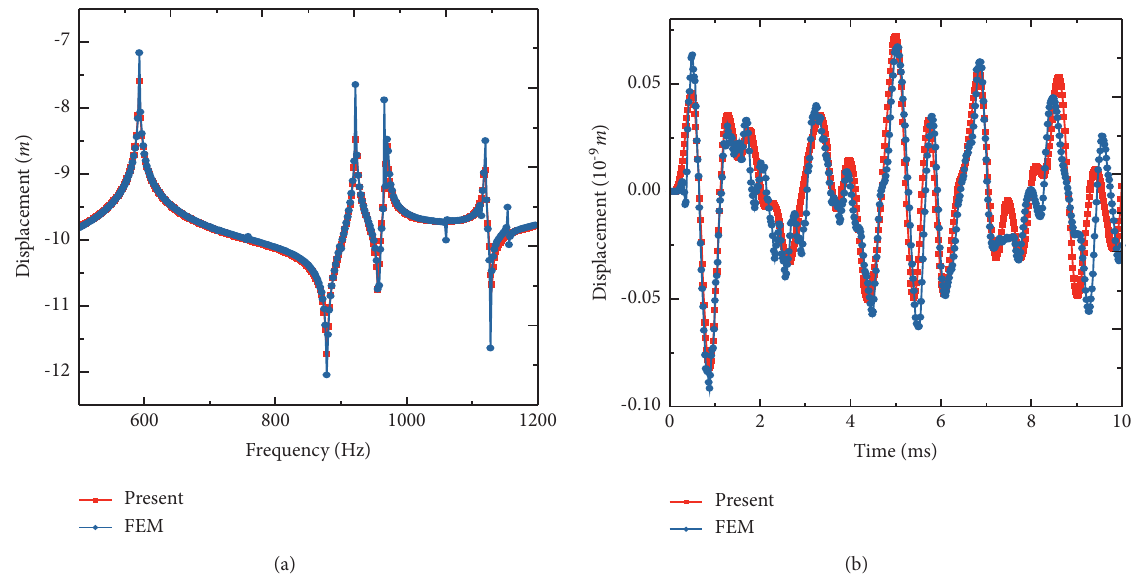
Figure 6: Verification of the correctness of responses: (a) steady-state response; (b) transient